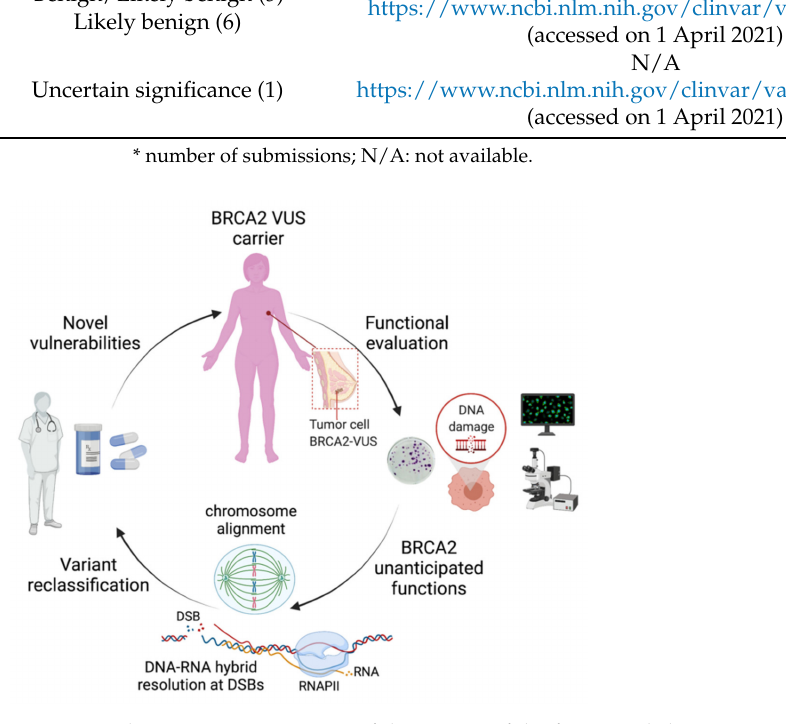
Figure 1. Schematic representation of the impact of the functional characterization of VUS